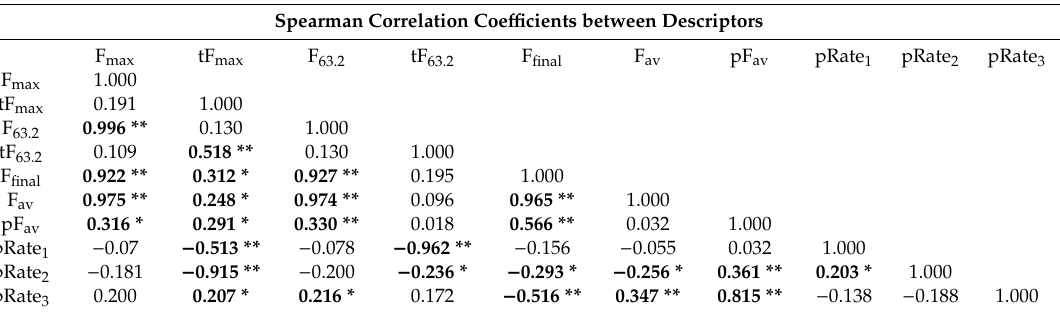
Table 4. Two tailed Spearman correlation coe ffi cients.